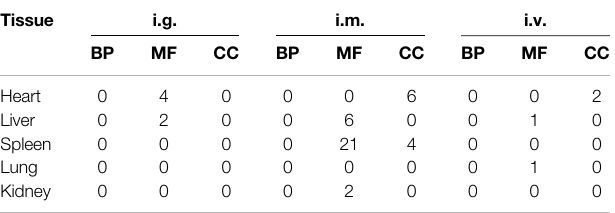
TABLE 3 | The number of enriched GO terms of tissues (heart, liver, spleen, lung, and kidneys) from the mice exposed by the intragastric (i.g.) administration, intramuscular (i.m.) injection, and intravenous (i.v.) injection. (adjust p value < 0.05, # of unique gene > 1). Tissue